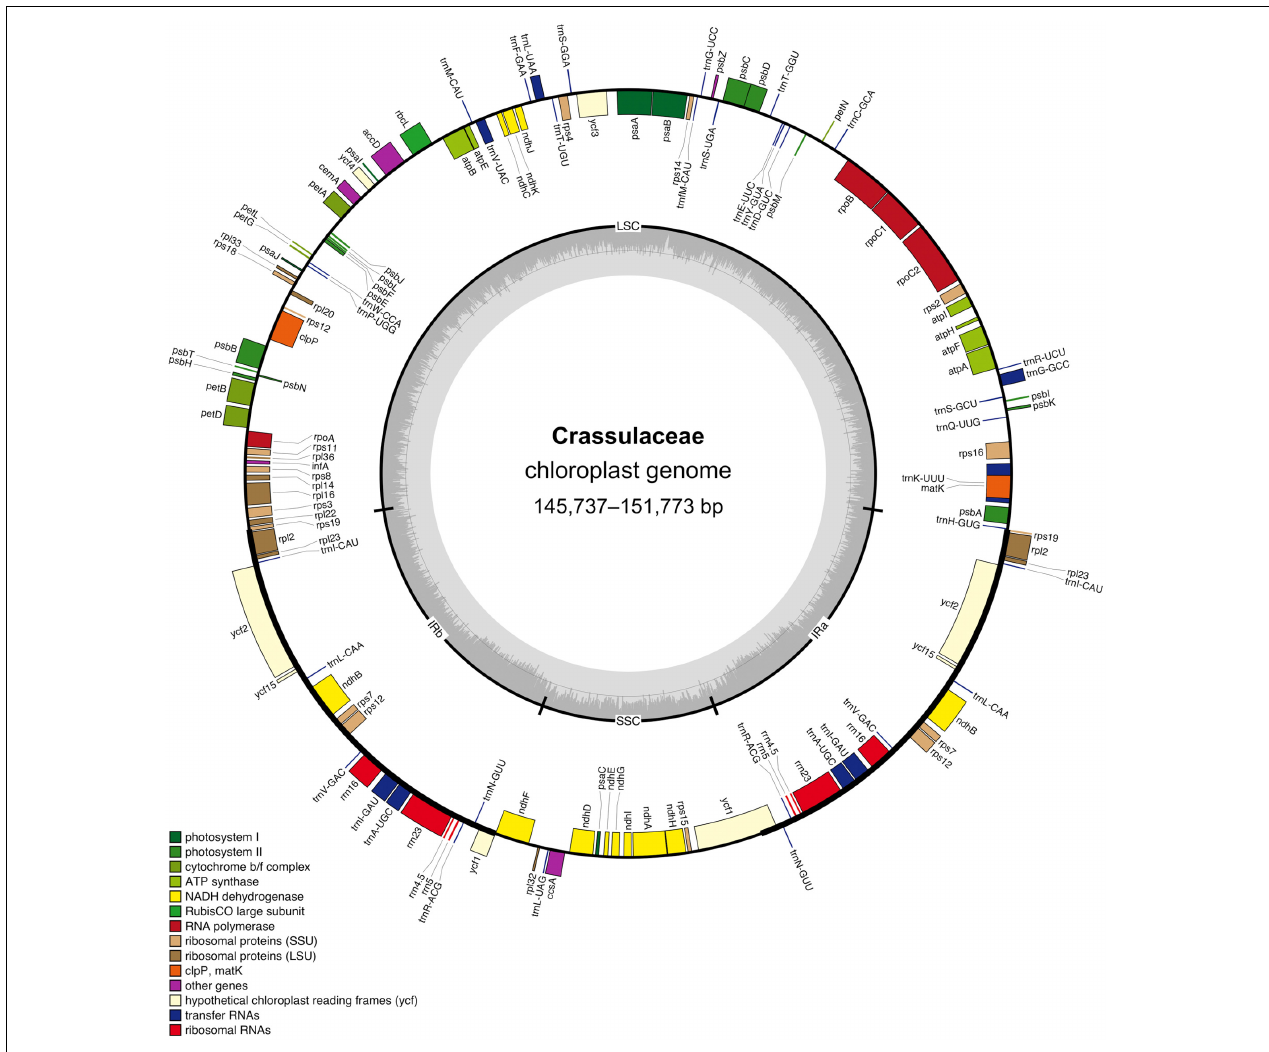
FIGURE 1 | Circular gene map of the Crassulaceae chloroplast genome. The genes labeled inside and outside of the circle are transcribed in clockwise and counterclockwise directions, respectively. The inner circle shows the quadripartite structure, with two IR regions (IRa and IRb) separating the large single-copy (LSC) and small single-copy (SSC) regions. The gray ring marks the GC-content with the inner circle indicating a 50%